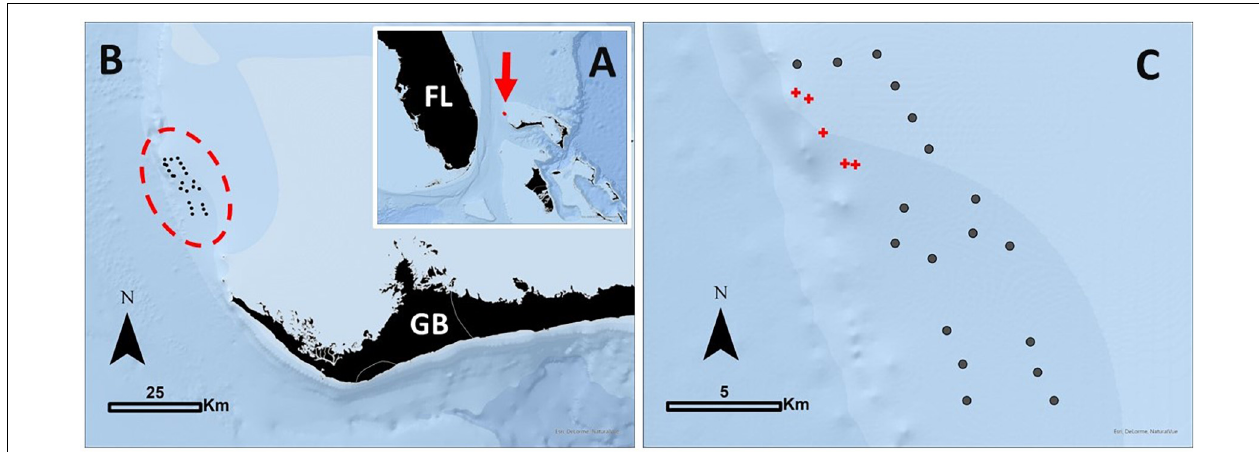
FIGURE 1 | (A) The location of the study area in the northern Bahamas identified with a red arrow. FL, Florida, United States, as a spatial reference. (B) Positioning of the telemetry array on the north-western edge of the Little Bahama Bank, off Grand Bahama [GB] Island. The 23 receivers used in this study are outlined in a red dashed oval. (C) Receivers were arranged in a roughly 12 km × 3 km rectangle, with the western line just inshore of the bank edge. Receivers in locations exposed to provisioning from commercial shark dive operations are identified with red crosses, referred to in the text as provisioning [P] sites. All other receivers are identified with gray circles, referred to in the text as non-provisioning [NP]